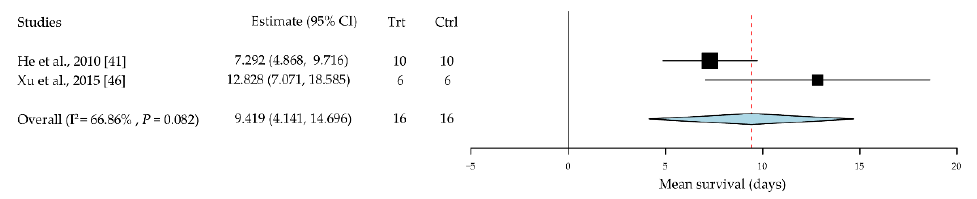
10 of 20 Figure 4. Blockage of co-stimulatory pathways influences corneal-allograft survival. ( A ) CLTA-4 Ig promotes allograft survival. ( B ) Anti-CD154 antibody increases the allograft survival rate. ( C ) CCR7-CCL19 blockade improves the allograft